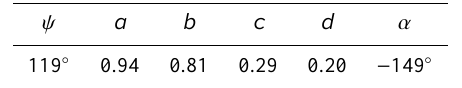
Figure 12. Comparison of preshaping motions. Table 3. Two-phalanx finger second optimal geometric